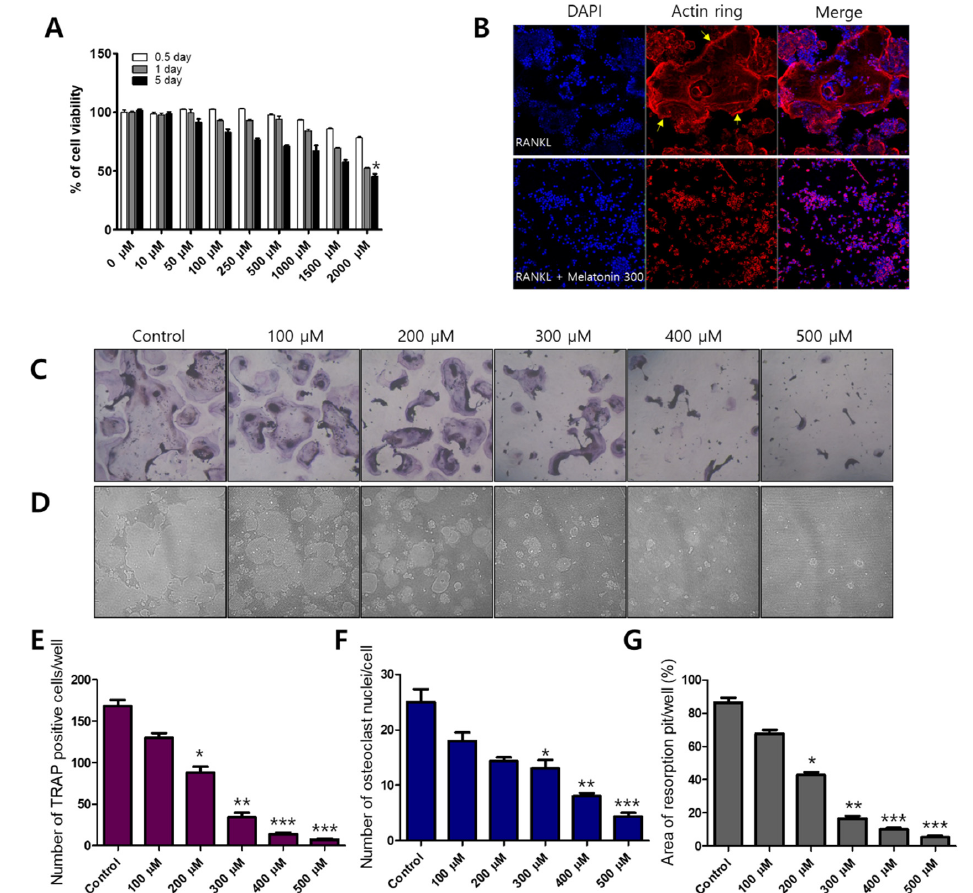
Figure 1. Inhibitory effect of melatonin on RANKL-induced osteoclastogenesis. ( A ) Cell viability of RAW 264.7 cell macrophages treated with various concentrations of melatonin for 0.5 to 5 days according to MTT assay. ( B ) RAW264.7 cells were cultured with RANKL or RANKL + melatonin for 5 days. Cells were stained with fluorescein rhodamine phalloidin to detect the presence of actin rings. The yellow arrow indicates the edge of the actin ring. ( C , E ) Number of TRAP-positive multinucleated RAW 264.7 cells containing three or more nuclei after treatment with 10 ng/mL RANKL and 100 to 500 μ M melatonin. ( F ) Number of osteoclast nuclei. ( D , G ) Resorption pit formation and resorption areas expressed as area of pit formation with respect to total area. Values represent the means of three independent experiments ± SDs ( n = 6). * p < 0.05, ** p < 0.01, and *** p <0.001 compared with the control.